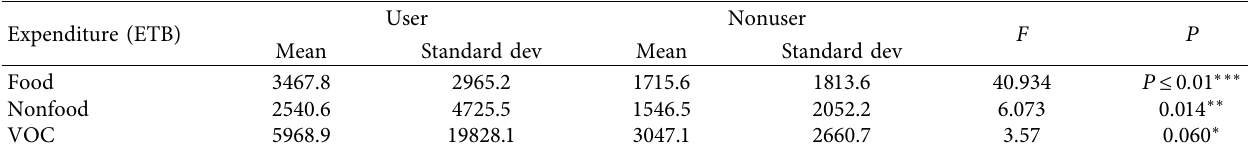
Table 8: Expenditure pattern of households with and without irrigation.